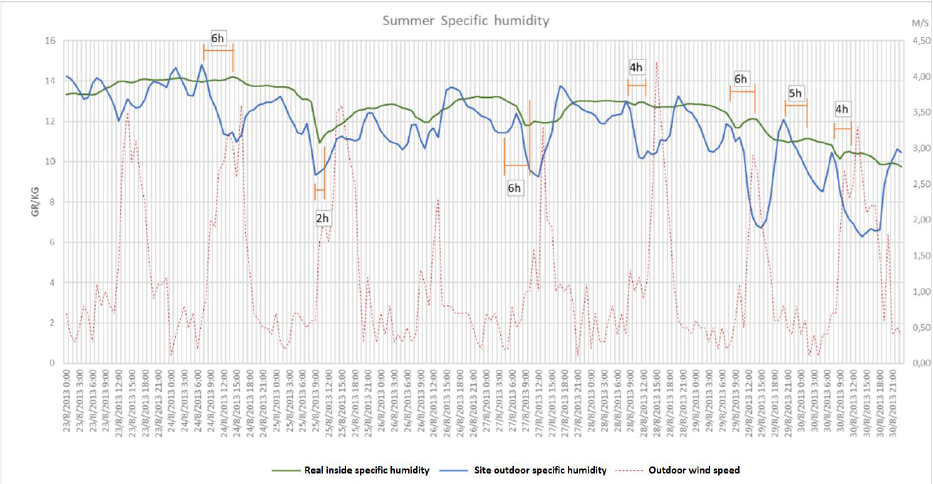
Figure 8. Winter specific humidity.